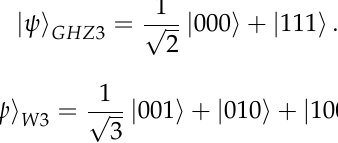
and B (cid:48) , and the 3-qubit GHZ state 2 1 and B (cid:48) , 2 1